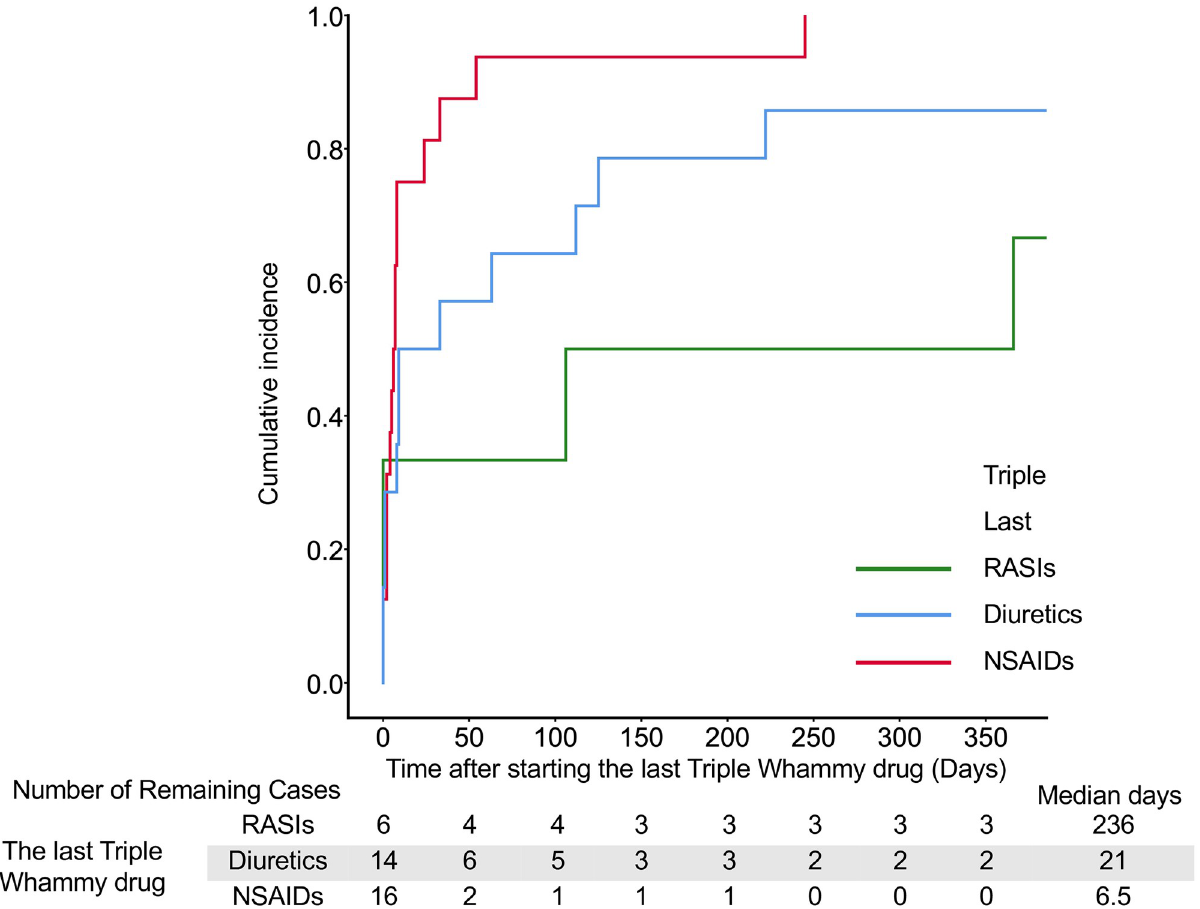
Fig 5. The cumulative incidence with the last TW drugs in the triple drug group. Cases in which multiple TW drugs were started at the same time were excluded. Median days indicate the date when the cumulative failure rate reached 50%.